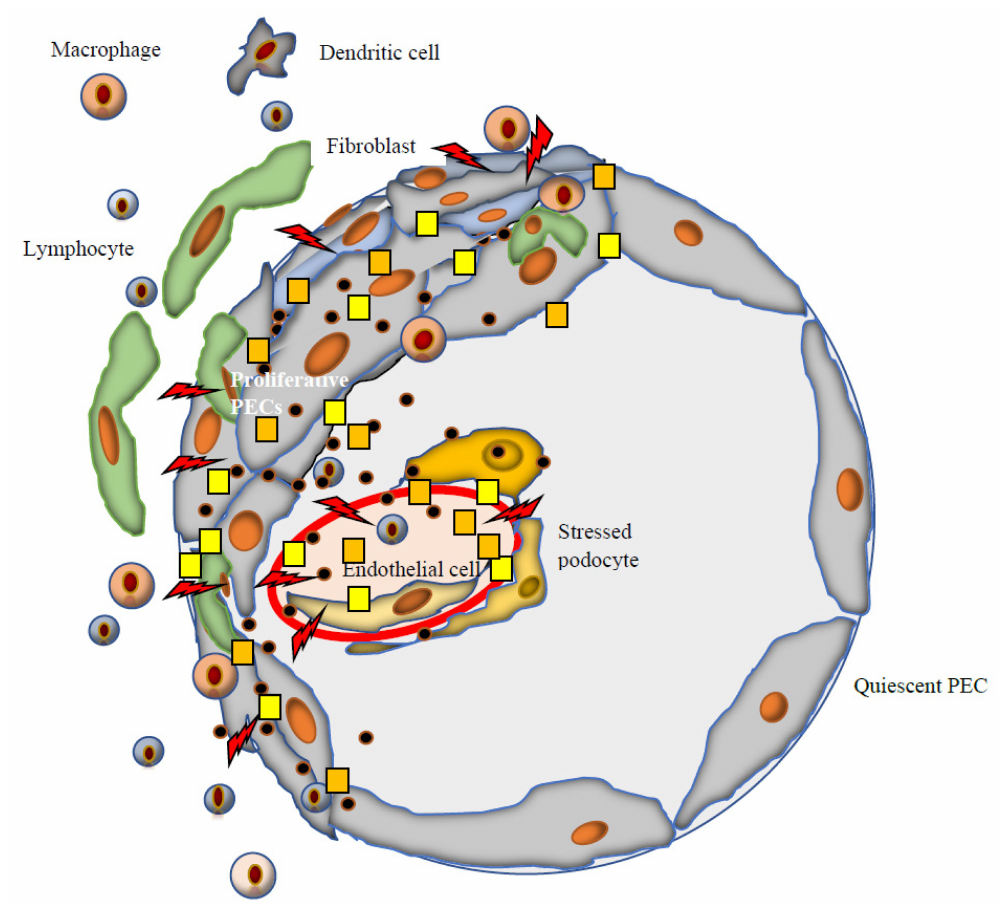
Figure 1. Main cells and molecules involved in crescent development in IgAN. In IgAN, crescent formation could be divided into two steps. First of all, there is an initial damage to the endothelium of the glomerular filtration barrier (rents )from where podocytes and parietal cells interact within and outside the surrounding glomerulus. The second step is the consequence of this interaction: The development of the crescent itself. Main molecules involved: Fibrinogen and fibrin-related antigens , type IV and V collagens, laminin, fibronectin, cytokeratin persistently positive at all stages of crescents, as well as vimentin, distributed in podocytes and parietal epithelial cells (PECs). At early stages of crescent formation in IgAN, podocytes play a key role, while the accumulation of basement membrane components adds to the progression of the crescents (Figure 1). In IgAN, endothelial proliferation associates with crescent appearance. Crescent formation in IgAN is associated with activation of the lectin and alternative pathways